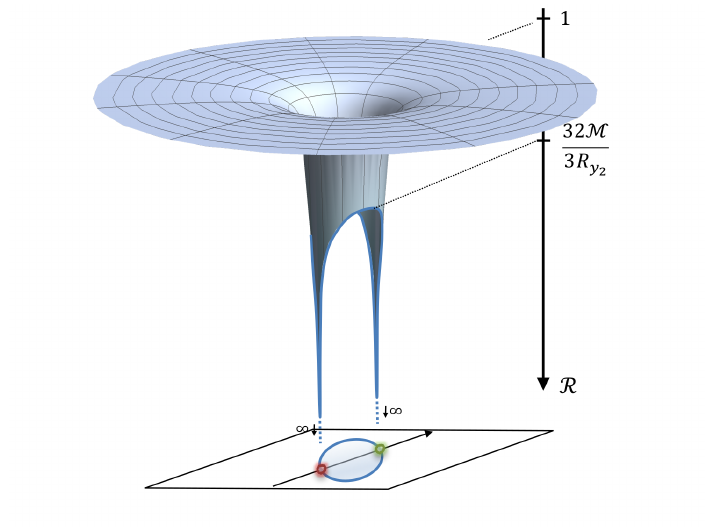
Figure 2 . Redshift factor of a neutral bound state of two extremal D1-D5 and D1-D5 black holes at the poles a vacuum